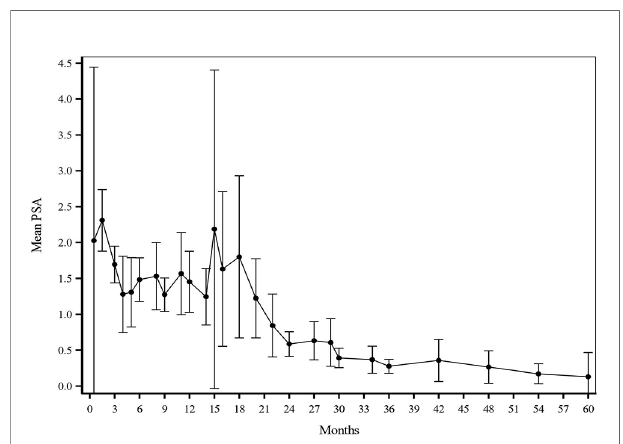
TABLE 2 | Patient baseline characteristics.